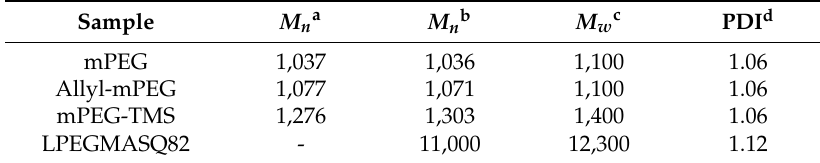
Table 1. Molecular weight and molecular weight distributions for selected materials.